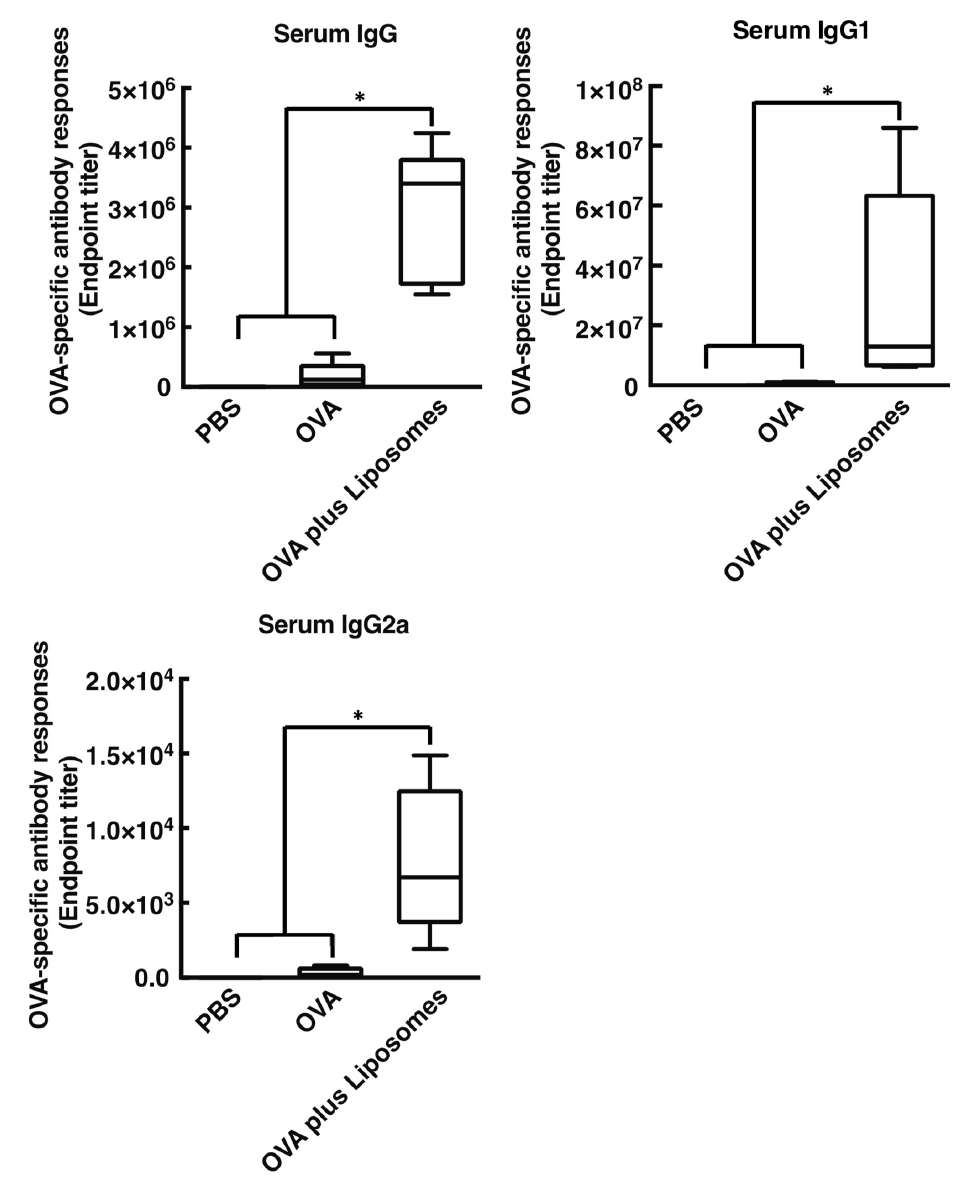
Figure 2. The cationic liposomes stimulate antigen-specific systemic antibody responses. BALB / cCrSlc female mice were immunized intranasally (days 0, 7, and 14) with PBS, OVA (2.5 µ g / mouse) alone, or OVA (2.5 µ g / mouse) together with DOTAP / DC-chol liposomes (400 nmol / mouse). OVA-specific serum IgG, serum IgG1, and serum IgG2a titers at day 21 were determined by an ELISA assay. Data were acquired from at least three biologically independent experiments. The box-plot represents median values with 25th–75th percentiles with error bars indicating 5th–95th percentiles. Significant differences were calculated by Kruskal–Wallis with Dunn’s post-hoc test. * p < 0.05.